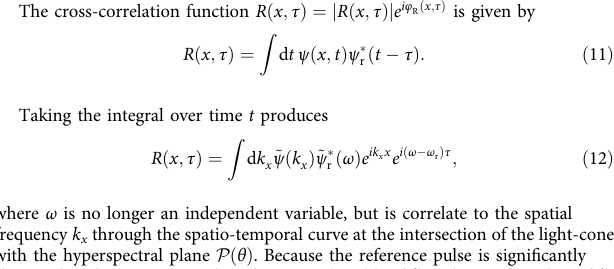
ffiffiffiffiffiffiffiffiffiffiffiffiffi q j 1 þ tan θ 1 (cid:2) tan θ